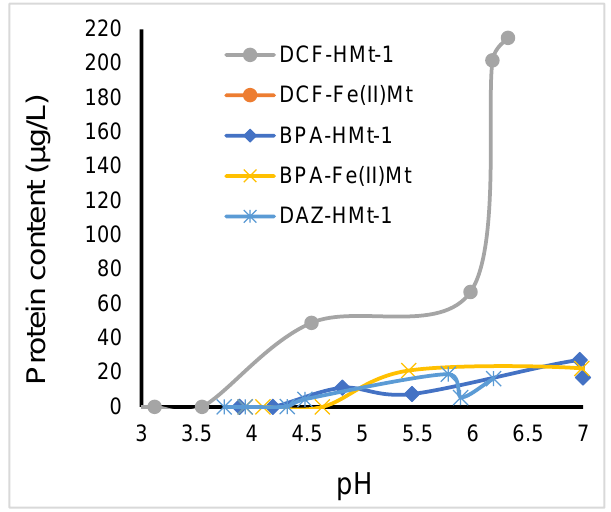
Figure 11. Effect of pH of the ozonized clay-substrate mixtures on protein content. The Chl A /Chl B ratio was measured by spectrophotometry at 620 and 665 nm based on Lichtenthaler – Buschman equations. The toxicity tests were achieved i. at constant pH 6.5 adjusted after ozonation and ii. at pH i , the pH of the SIS mixture with the solution of the organic substrate before and after ozonation at different times.